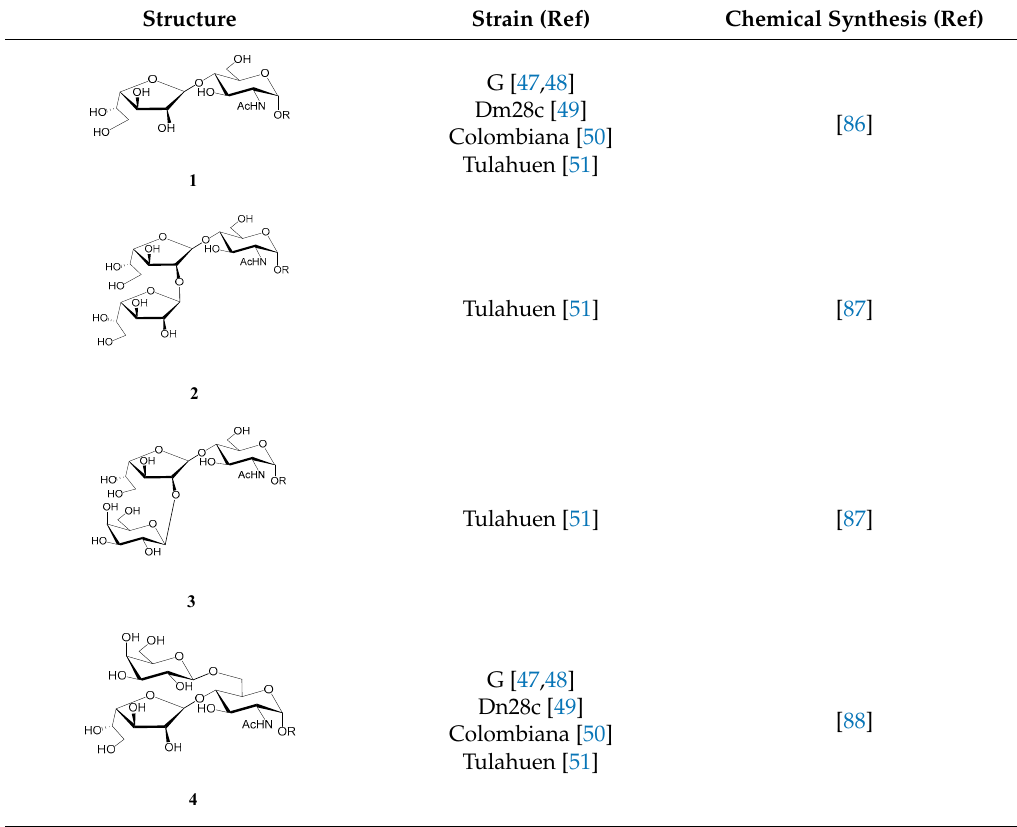
Table 1. O -linked carbohydrates derived from core 2 in the mucins of T. cruzi. Structure Strain (Ref) Chemical Synthesis (Ref)